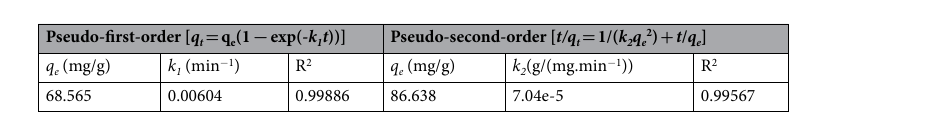
Table 2. Kinetics data of pseudo-first-order and pseudo-second-order model for the adsorption of